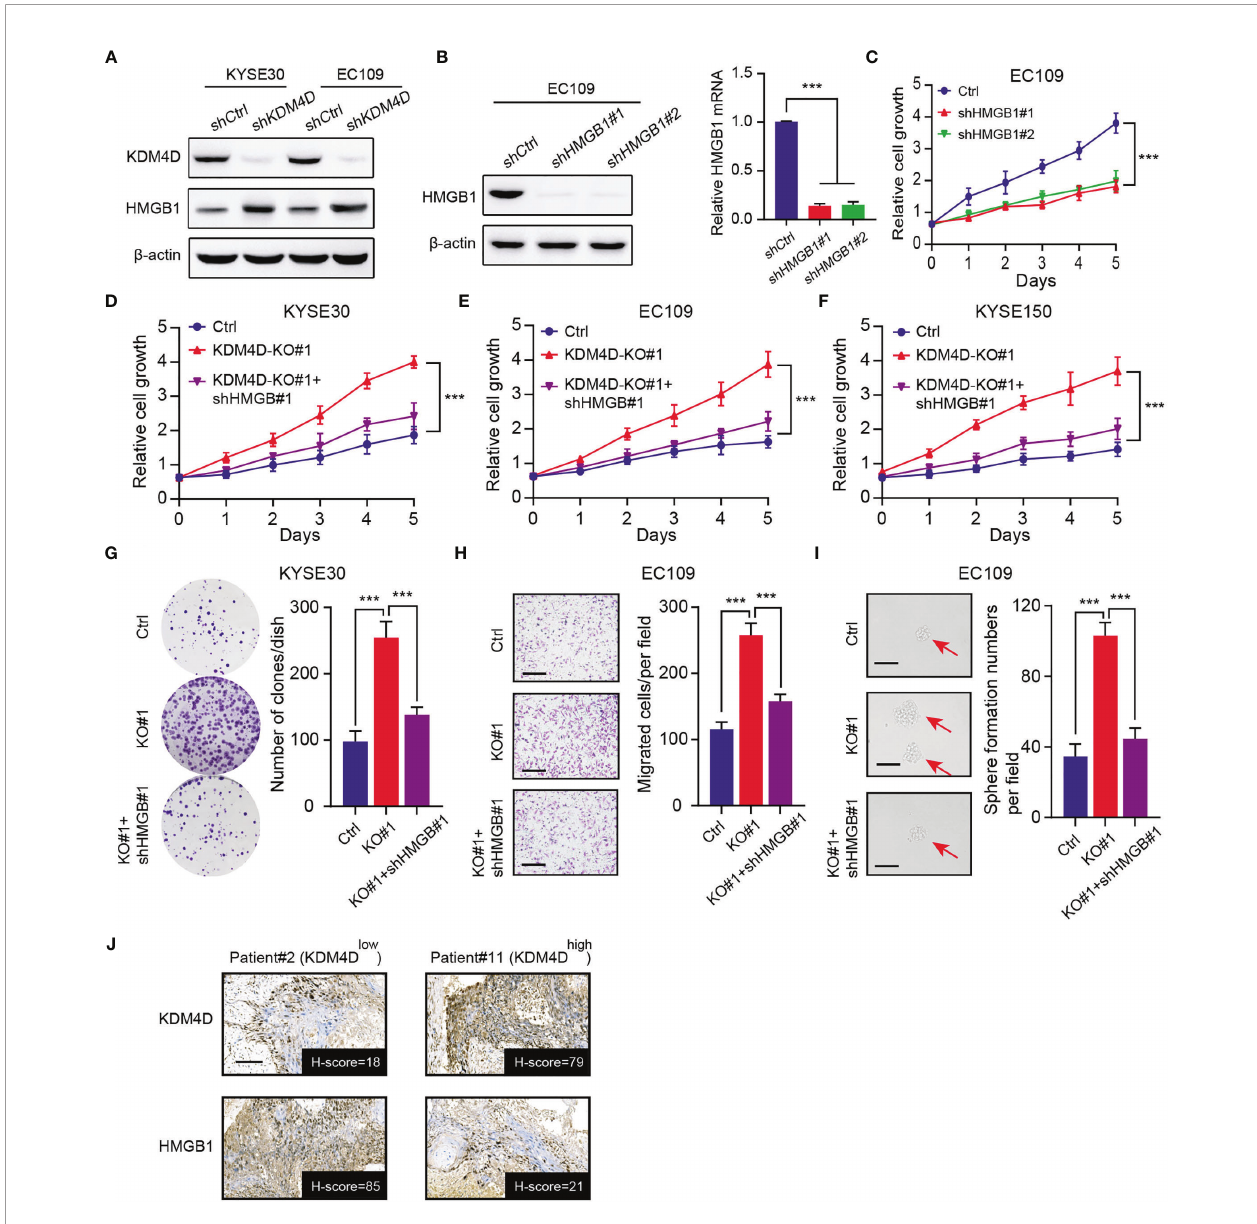
FIGURE 4 | Low KDM4D depends on elevated HMGB1 to promote ESCC progression. (A) Western blot assays detecting the protein levels of KDM4D and HMGB1 in KYSE30 and EC109 cells. (B) Western blot exhibiting the knockdown ef fi ciency of KDM4D by speci fi c shRNAs in EC109 cells (left). qPCR assay revealing the mRNA levels of HMGB1 (right). (C) CCK-8 assays revealing the cell growth differences in Ctrl and HMGB1-knockdown EC109 cells. (D – F) HMGB1 knockdown signi fi cantly suppressed the cell growth in KDM4D-de fi cient cells (KYSE30, EC109 and KYSE150), as indicated by the CCK-8 assays. (G) HMGB1 inhibition signi fi cantly impaired the clone formation ef fi ciency in KDM4D-de fi cient KYSE30 cells. (H) HMGB1 inhibition signi fi cantly impaired the migration ef fi ciency in KDM4D- de fi cient EC109 cells. (I) HMGB1 inhibition signi fi cantly impaired the self-renewal ability in KDM4D-de fi cient EC109 cells. (J) Representative images showing the negative associations of KDM4D and HMGB1 protein levels. Scale bar = 80 m m. * P < 0.05, ** P < 0.01, *** P <